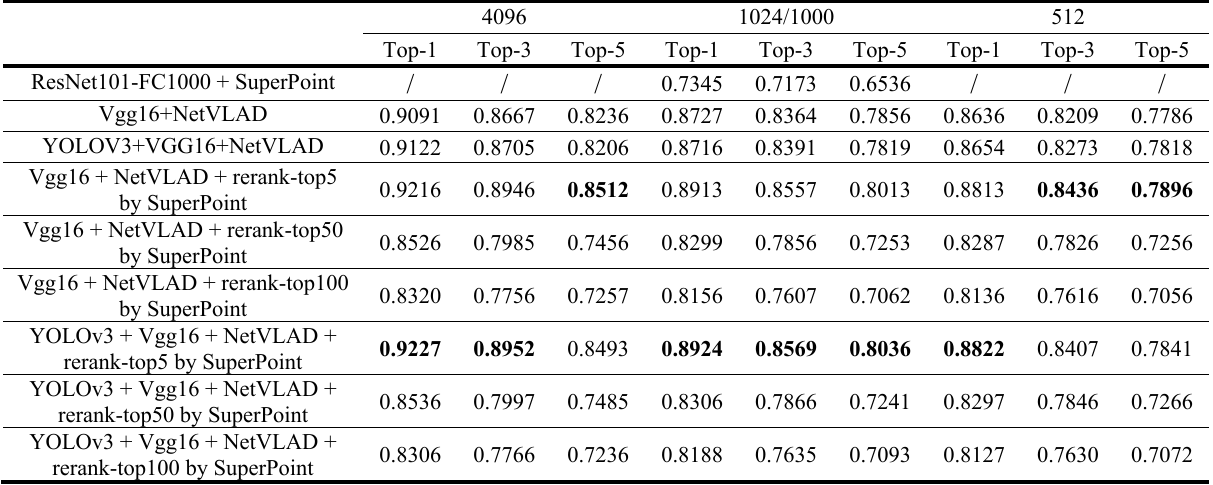
Table 3. Precision results of various hierarchical retrieval solutions on Oxford Buildings dataset. The precision of nine tests